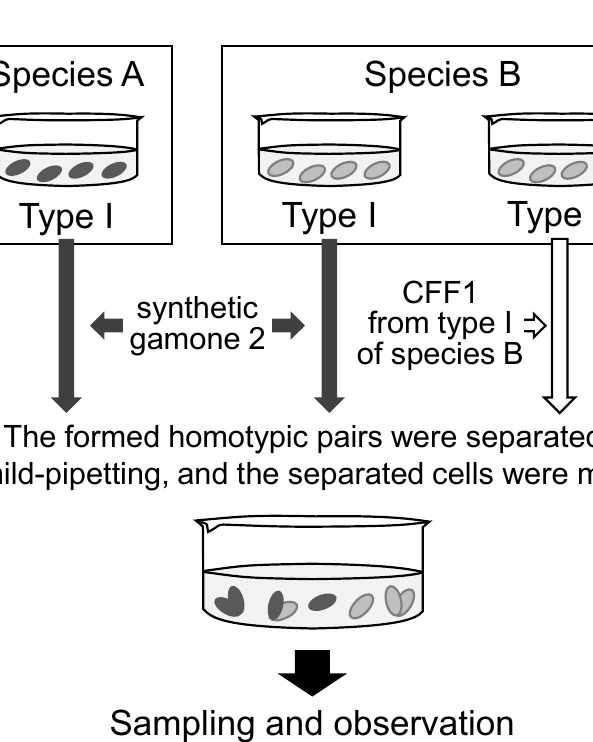
Figure 1. Procedure for the induction of mating pairs between different species.